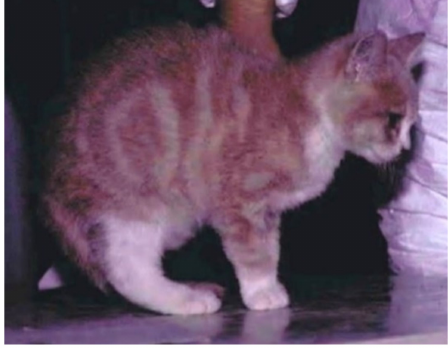
Figure 3. Calicivirus infection limping syndrome. ©Uwe